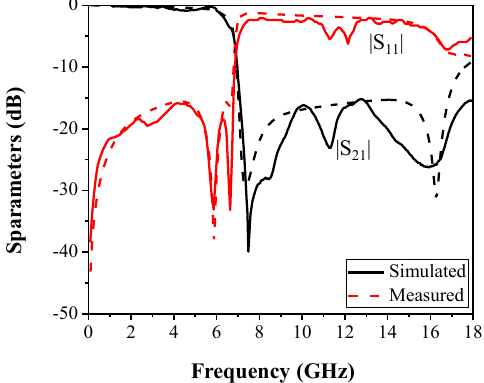
Figure 10: Measured (solid line) and simulated (dash line) frequency responses of the proposed LUC.